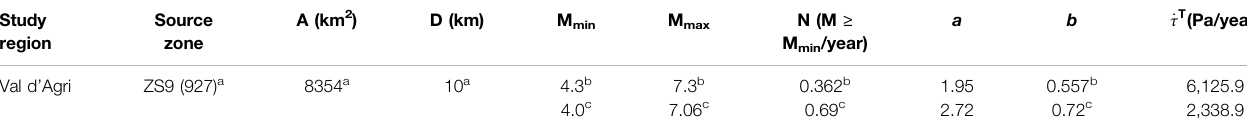
TABLE 3 | Source parameters and resulting tectonic stress rate for the VA region considering two different parameter sets taken from different references. Study